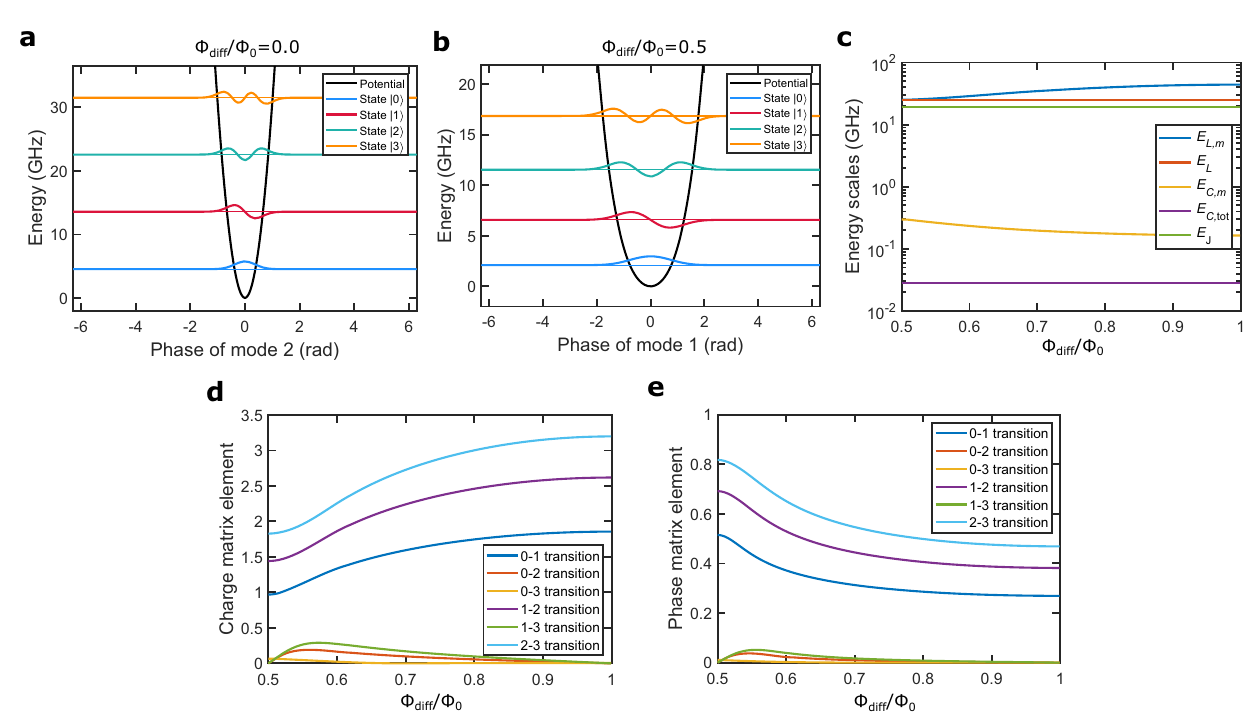
mean from three consecutive randomized benchmarking experiments. The dashed black line shows the coherence limit that has been computed using the mean values of T 1 and T e 2 measured interleaved with the gate fi delity. The left inset illustrates the decay of the sequence fi delity asafunctionof itslength in an exemplary randomized-benchmarking experiment. The right inset shows the histogram of the gate fi delities obtained over the measurement period of eight hours. c Stability of T 1 , T e 2 , and the Ramsey coherence time T * 2 over a period of eight hours. The qubit parameters were calibrated only once before the char- acterization measurements. The error bars represent the standard error of the mean from three consecutive measurements.